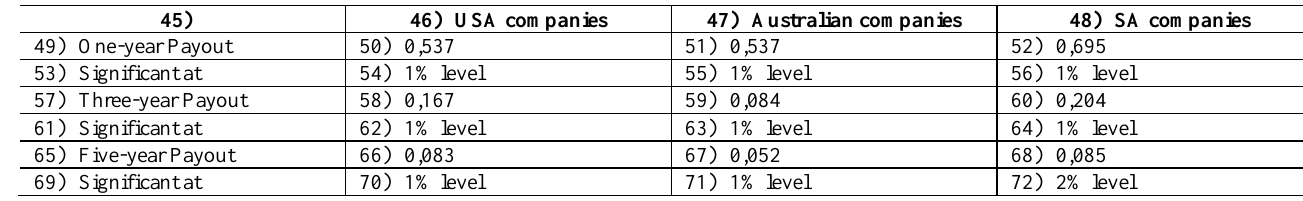
Table 8: Comparison – payout